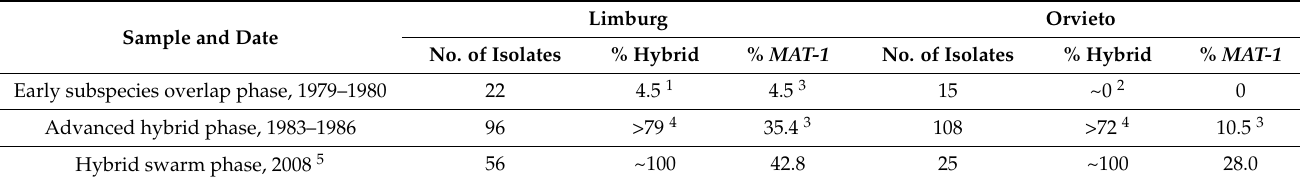
Table 1. Change in frequency of the MAT-1 sexual compatibility type at the Limburg and Orvieto sites. Sample and